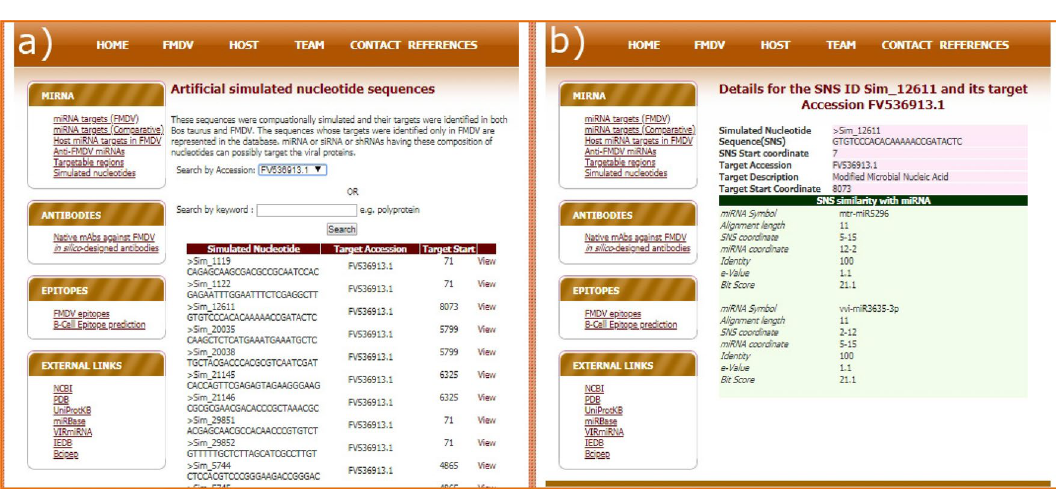
Figure 6. ( a ) Search interface and ( b ) result page for the putative targetable regions on the FMDV accessions.